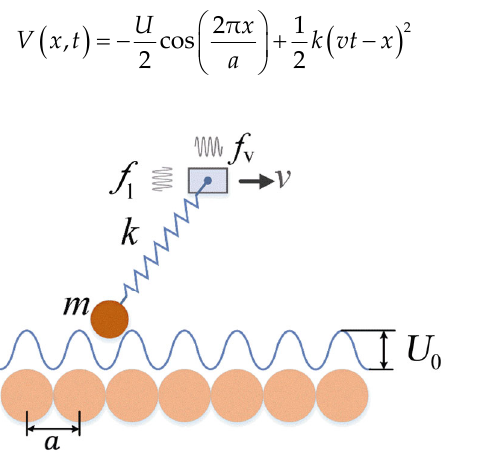
Fig. 11 Schematic of a 1D PT model, showing the relationship between AFM tip/cantilever and sample. Rectangular block (sliding support) leads the red solid sphere (tip atoms) through a corrugated potential energy landscape. f v and f l are vertical and lateral